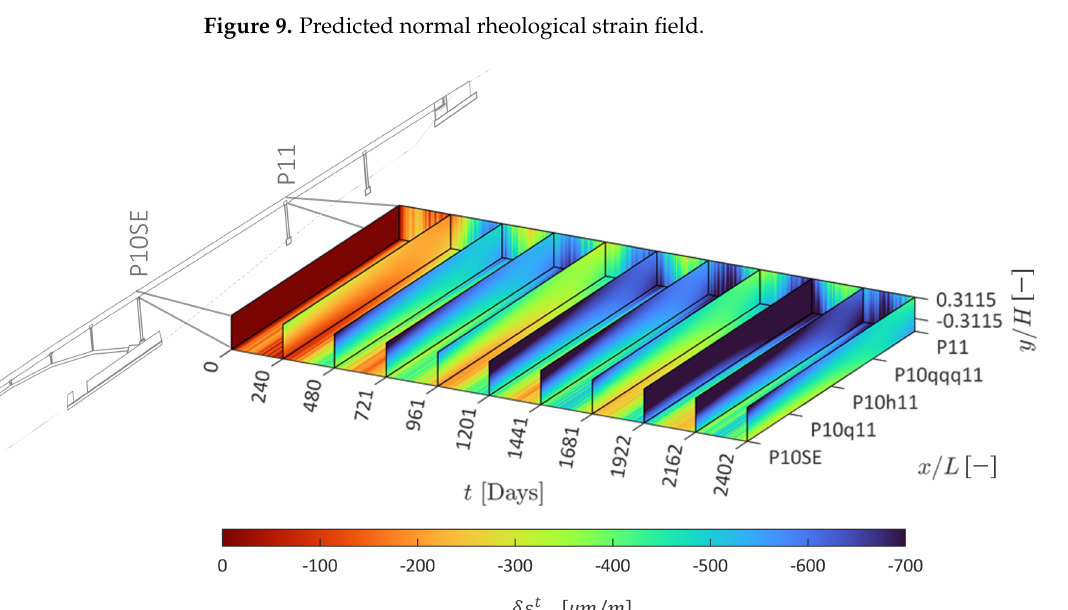
Figure 10. Predicted normal total strain